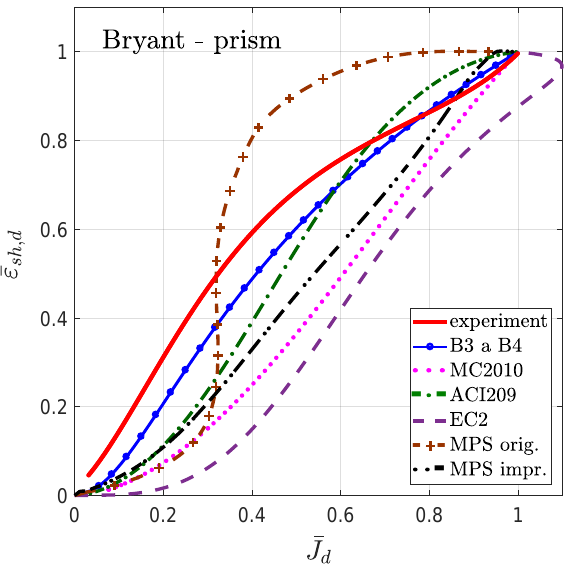
Figure 9. The comparison of the experimental data, prediction models and FE simulations of the Bryant’s experiment, 2 V/S = 150 mm (slab).